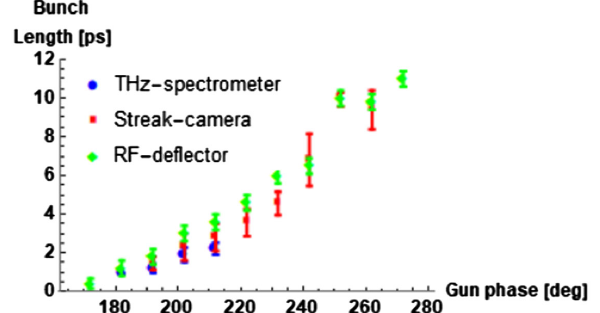
FIG. 9. Bunch length measurements with different techniques/ placed at different points of the beamline. A full range 0.5 ps to ∼ 10 ps has been